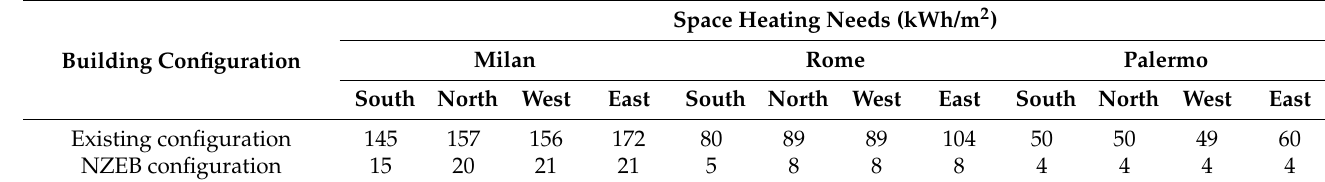
Table 4. Space heating energy performance with ACH 0.3 h − 1